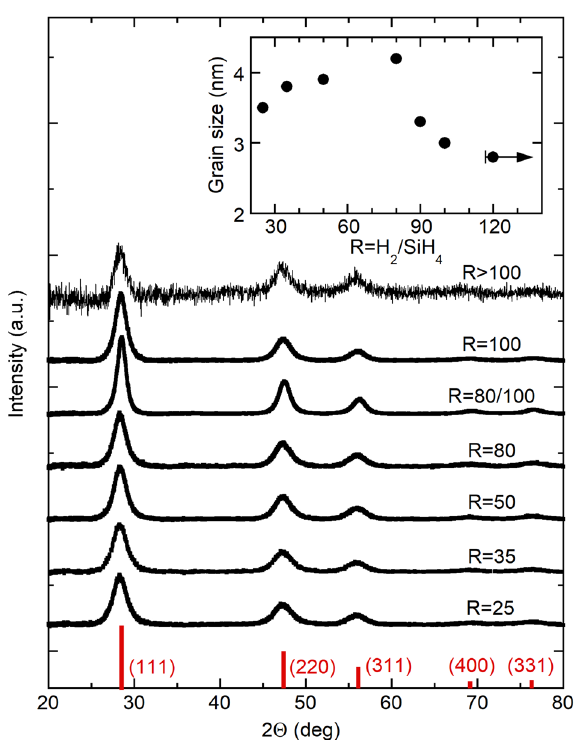
Fig. 1 Grazing-incidence X-ray diffraction patterns. For all seven plasma- enhanced chemical vapor-deposited nc -Si fi lms, the backgrounds are subtracted, integrated peak areas are normalized, and y -axes are shifted for clarity. The positions and the relative peak intensities of polycrystalline silicon (ICDD no. 03-065-0565) are at the bottom for reference. The R - dependent grain size is in the inset. The right arrow indicates the uncertainty in R for the R > 100 sample explained in the “ Results ”